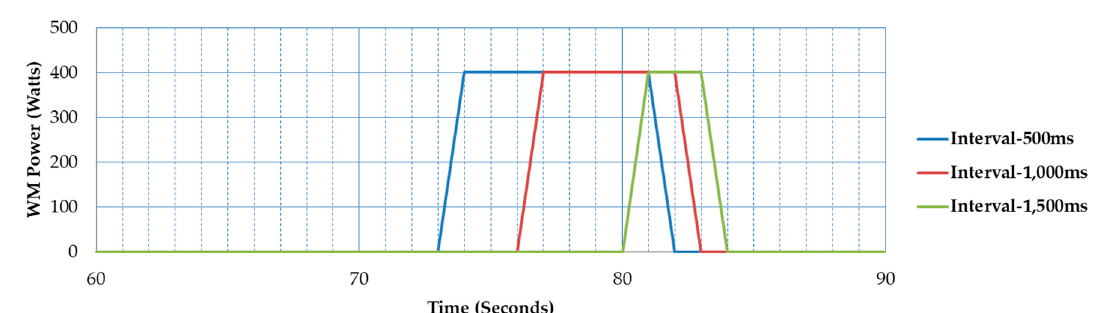
Figure 8. PV power simulated on a 10-s basis.